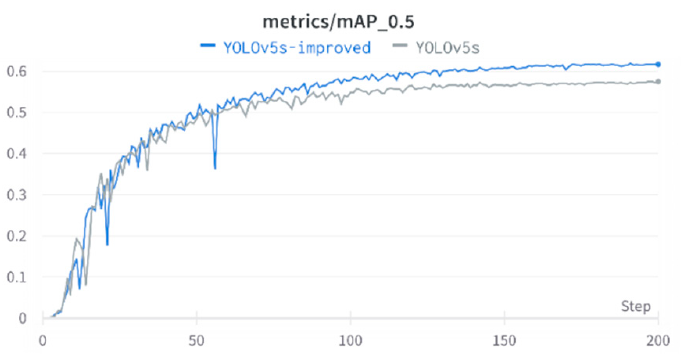
Figure 7. YOLOv5 ( a ) vs. YOLOv5s-improved ( b ) method Precision–Recall curves on the validation set. Figure 6. YOLOv5s vs. YOLOv5s-improved method Average Precision comparison on the validation set.